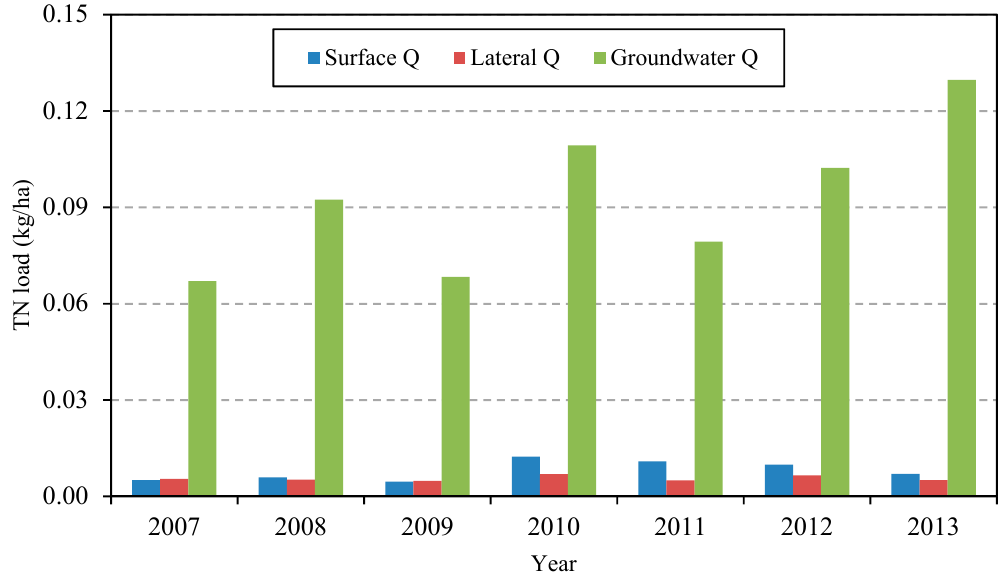
Figure 6. Total nitrogen in surface water runoff, lateral saturated water and groundwater.